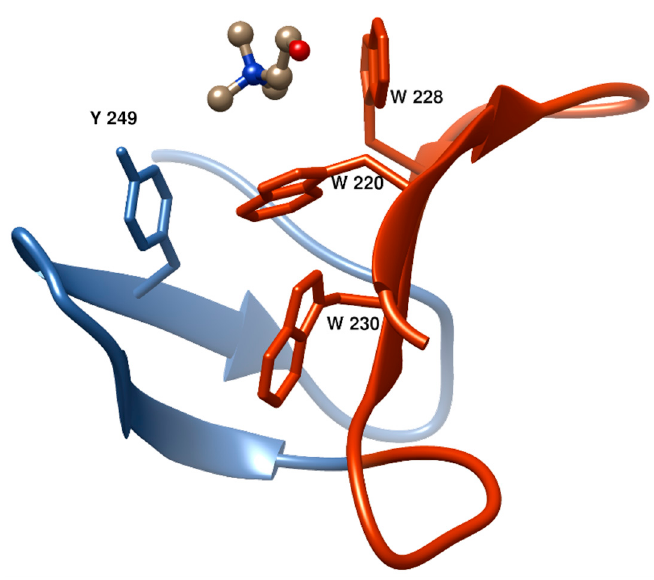
Figure 4. Structure of a typical choline-binding site in the LytA amidase [73] (PDB code; 1GVM] showing two consecutive CBRs (in blue and dark orange ) and the aromatic residues involved in choline binding. This and the rest of figures showing 3D structures were prepared with UCSF Chimera 1.10 [74].